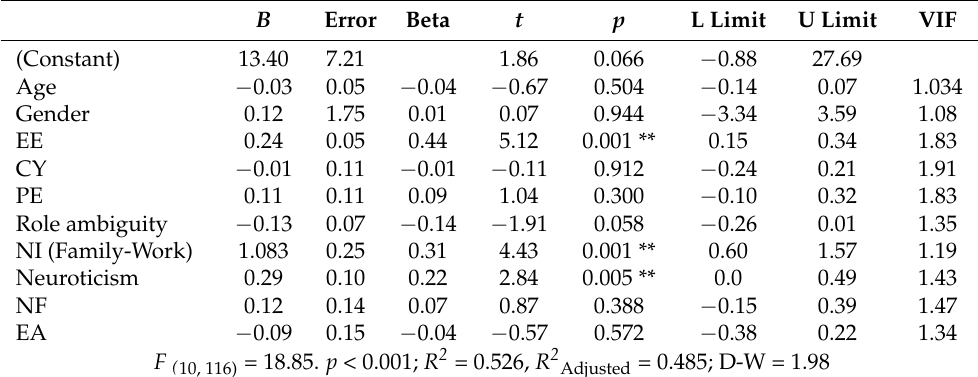
Table 4. Multiple regression for the dependent variable: General Health Questionnaire (GHQ-12). B Error Beta t p L Limit U